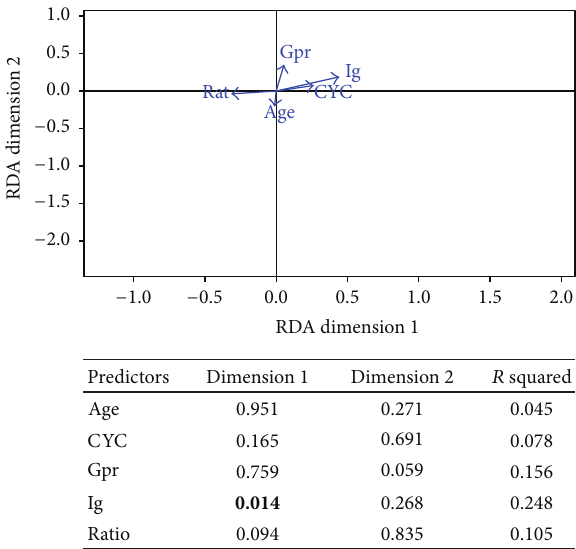
Figure 4: Redundancy analysis of the five predictors using the two best combinations of outcomes. 𝑃 values and 𝑅 squared of each predictor are presented in the included table. Age: age in years at rituximabinitiation;CYC:cyclophosphamidecumulativedose;Gpr: gram of RTX per round; Ig: total level of immunoglobulin prior rituximab; Rat: ratio CD4/CD8 prior rituximab; severe I: severe infection.